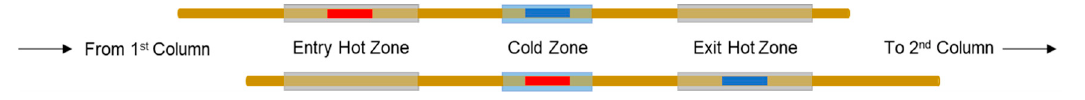
Figure 2. Diagram of dual-stage modulation in the SSM, based on Reference [13,15].